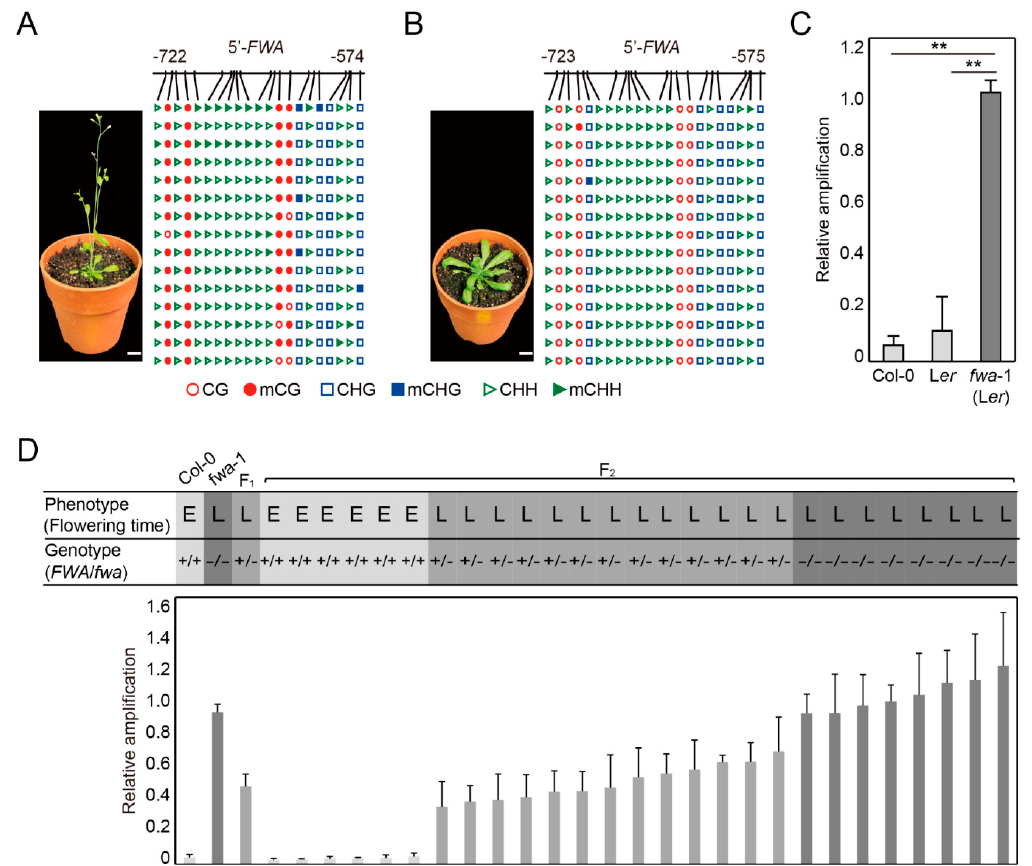
Figure 3. DME-qPCR for quantitative DNA methylation analysis for FWA alleles in Arabidopsis . ( A , B ) Flowering time phenotypes and DNA methylation profiles of Col-0 wild type ( A ) and fwa-1 mutant in the L er background ( B ). The 5 ′ - FWA represents an upstream region of the translation start site of FWA . DNA methylation patterns were analyzed using bisulfite sequencing. Genomic DNA isolated from individual plants was subjected to bisulfite sequencing analysis. Scale bar = 10 mm. ( C ) DME-qPCR analysis for wild type (Col-0 and L er ) and fwa-1 mutant plants. Relative amplifications were calculated using the ∆∆ Ct method with the value for unmethylated ASA1 gene as a control. Asterisks indicate statistically significant differences between wild type and fwa-1 (**: p < 0.01; Student’s t -test). ( D ) DME-qPCR analysis for FWA alleles in the F 2 population. F 2 population was generated by selfing F 1 obtained from a cross between wild type (Col-0) and fwa-1 (L er ). ‘E’ and ‘L’ indicate early and late flowering phenotype, respectively. ‘+’ and ‘ − ’ indicate wild type (Col-0) and fwa-1 (L er ) genotypes, respectively, at the FWA locus analyzed with the CAPS marker. Light, medium and dark gray colors indicate genotypes +/+, +/ − and − / − at the FWA locus. DME-qPCR amplification values were calculated relative to ASA1 . The data represent the mean ± S.D. of three replicates ( C , D